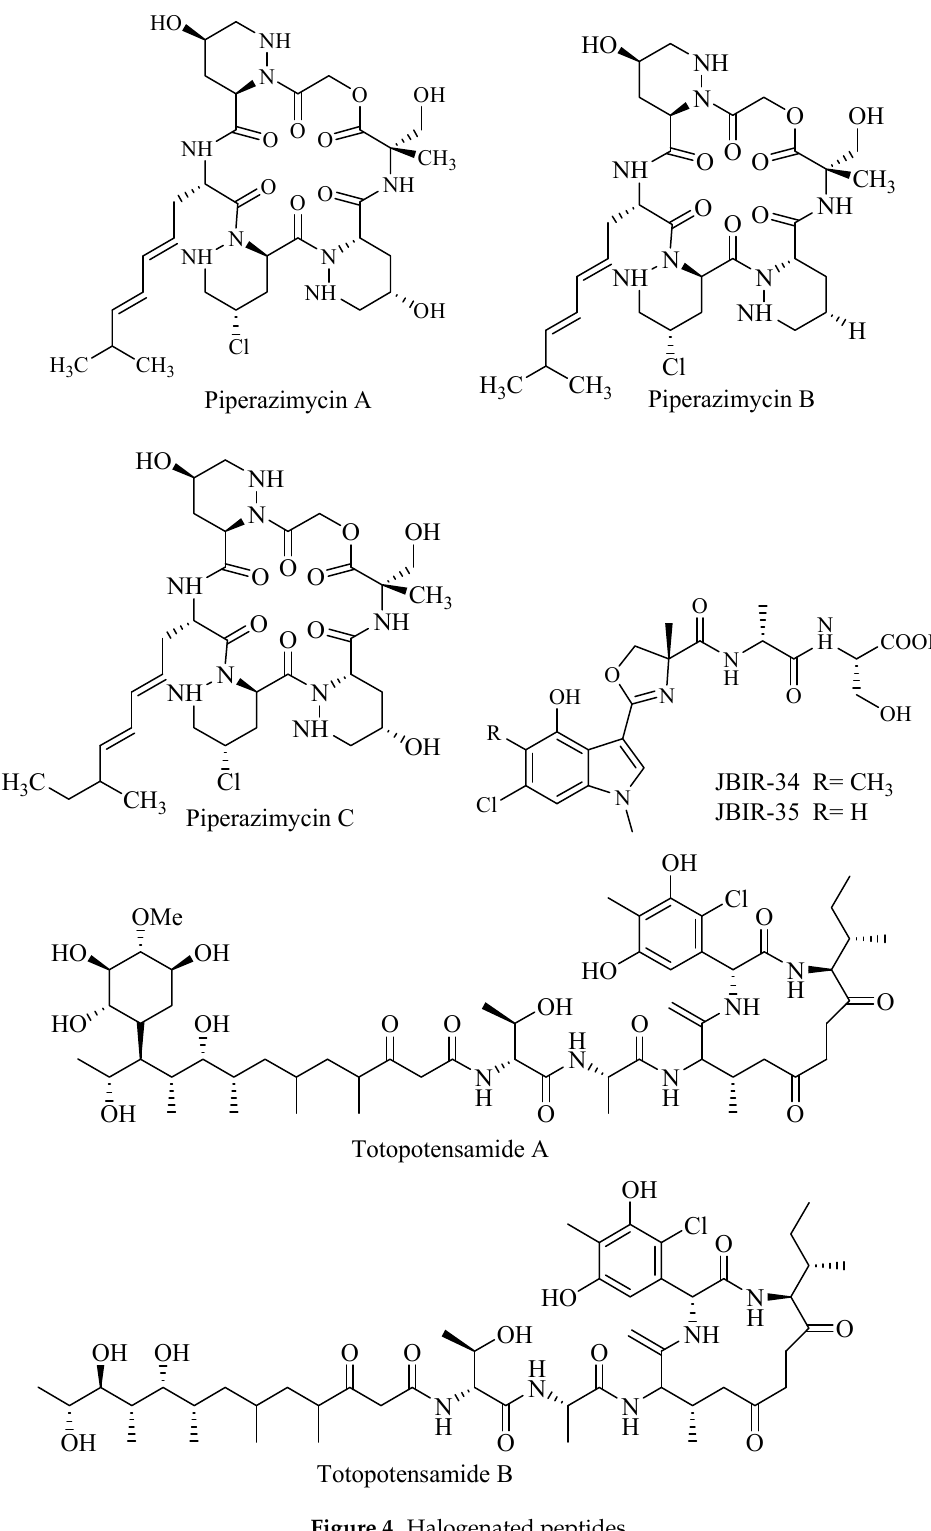
Figure 4. Halogenated peptides.